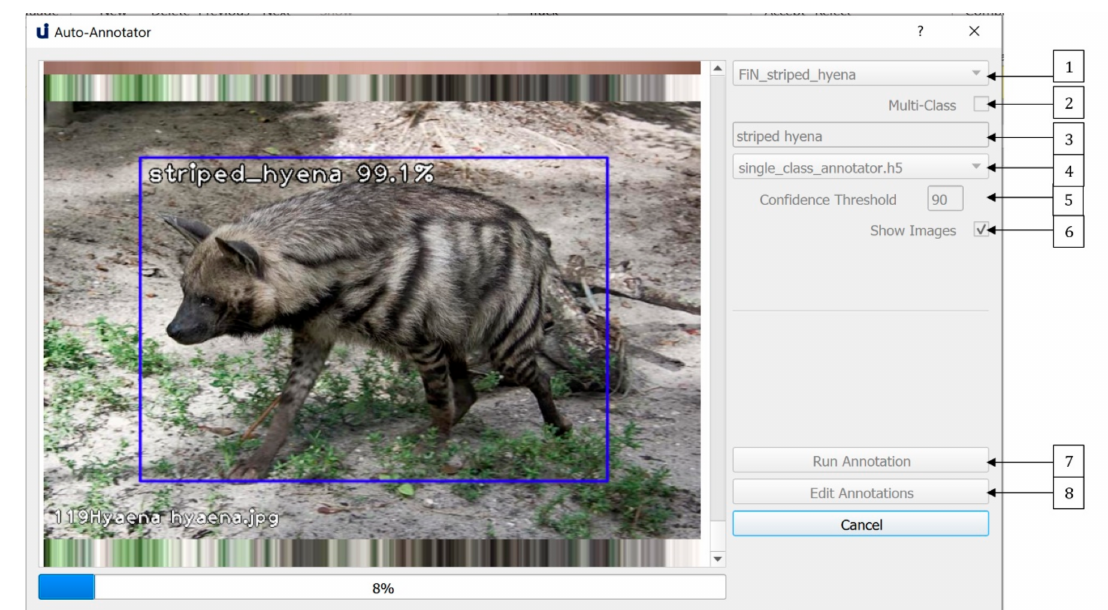
Figure 9. The Auto-Annotation dialogue allows users to achieve both single class and multi-class auto-annotation of images. Annotations can be edited via labelImg.